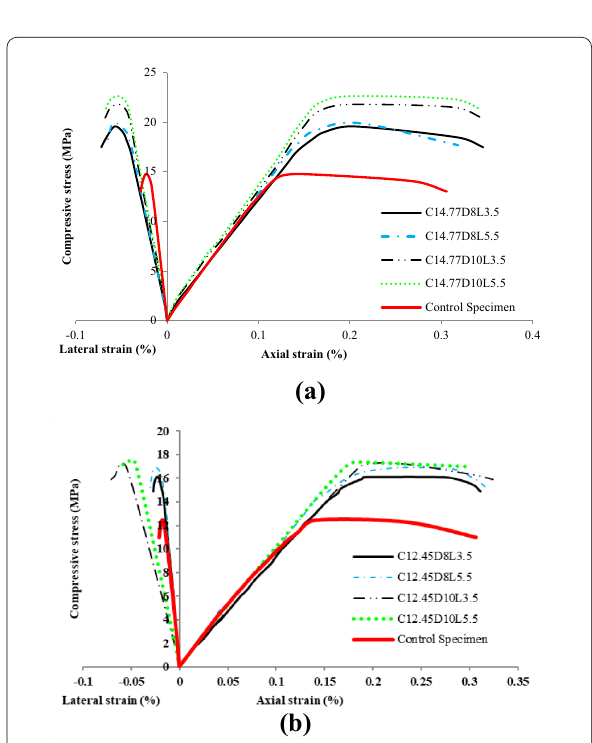
Fig. 6 Stress–strain diagram in specimens with compressive concrete strength of a 14.77 MPa, and b 12.45